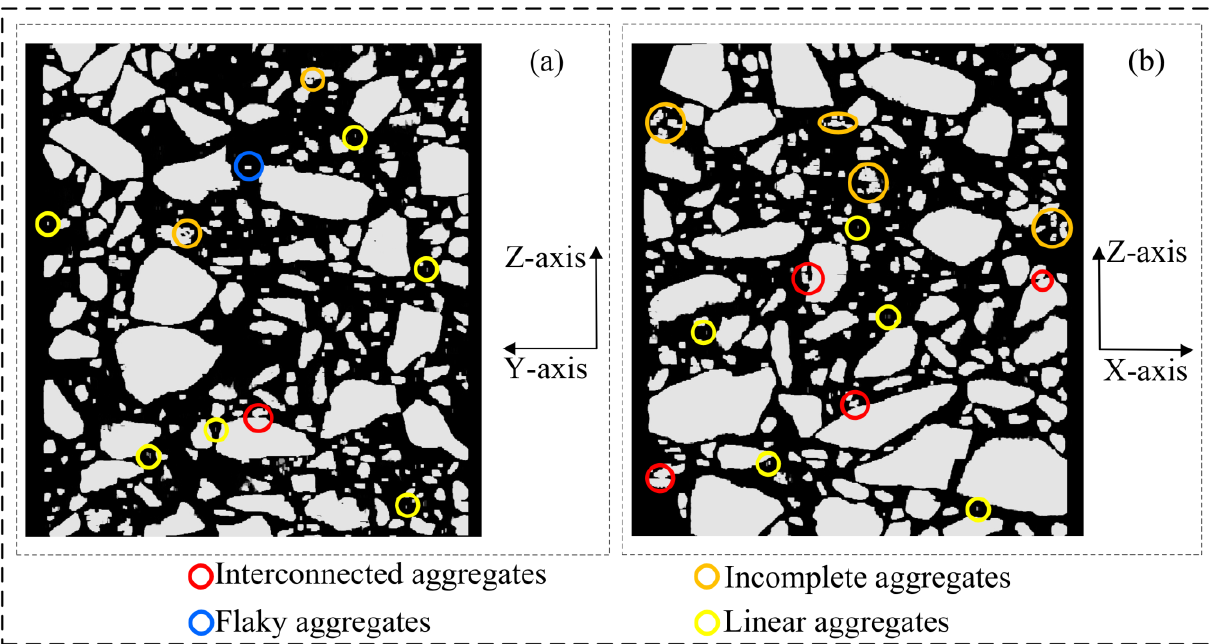
Figure 12. Three-dimensional asphalt concrete voxel model sections (corresponding to Figure 10b): ( a ) YZ section; ( b ) XZ section. ( a ) YZ section; ( b ) XZ